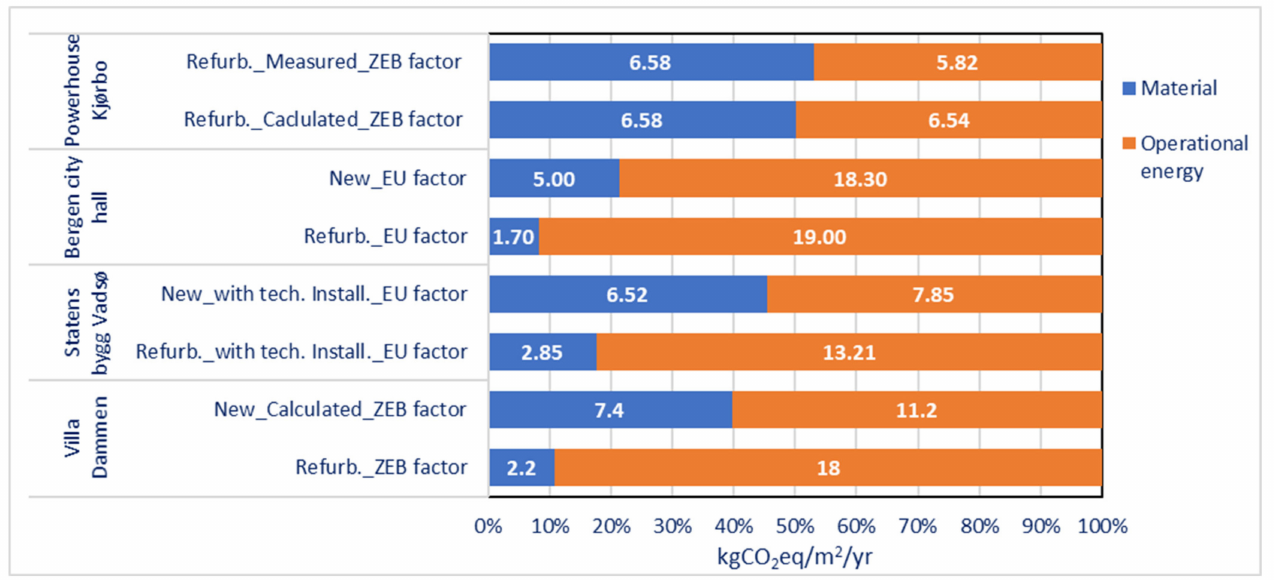
Figure 2. Embodied and operational GHG emission